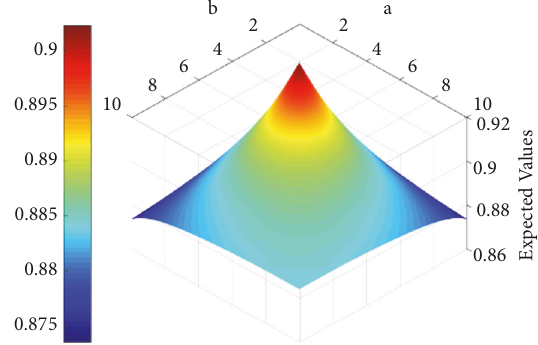
̃̃1) Figure 3: 𝐷(𝑅 1 − of Α 1 based on IT2FWPHM operator.